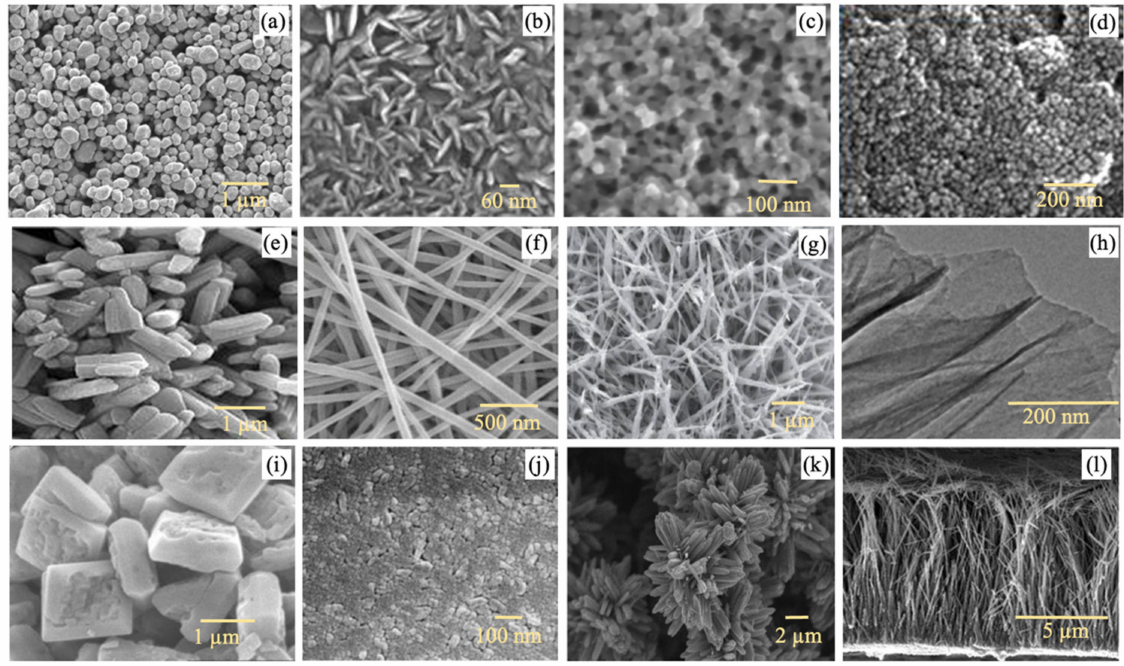
Figure 1. FESEM images of TiO 2 nanostructures with different sizes and shapes: ( a ) nanospheres [52], ( b ) nanoplatelets [53], ( c ) nanopores [54], ( d ) quantum dots [55], ( e ) nanorods [57], ( f ) nanofibers [58], ( g ) nanowires [59], ( h ) nanosheets [65], ( i ) nanoplates [66], ( j ) nanofilms [66], ( k ) nanoflowers [69], and ( l ) nanoforest structures [70]. Reprinted with